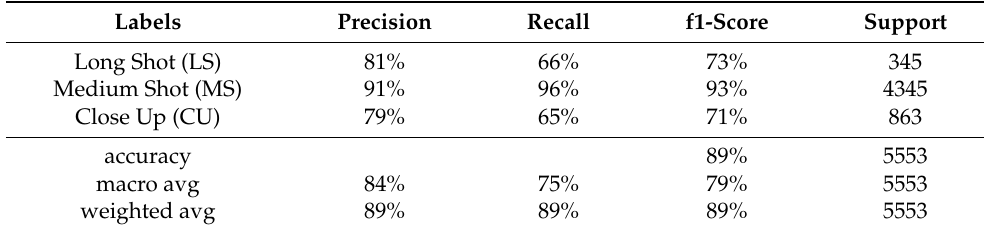
Table 22. Precision recall and f1-score of our methodology on a subset of the Cinescale Dataset. Labels Precision Recall f1-Score Support Long Shot (LS) 81% 66% 73% 345